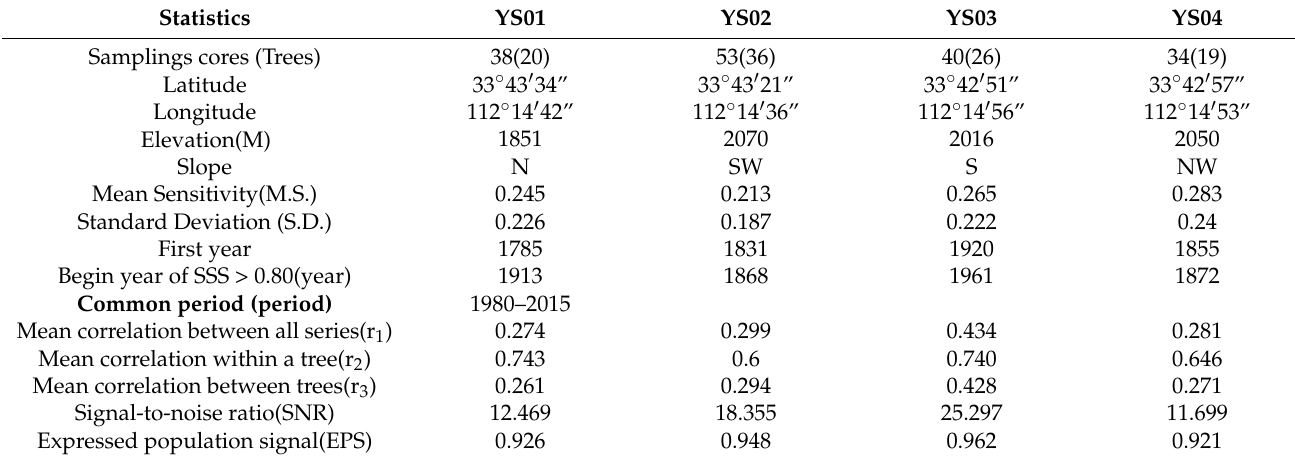
Figure 1. Locations of the sampling region (square) and sampling sites (triangle) in Mt. Yao and the nearby meteorological stations (dots) in the Funiu Mountains, central China. Table 1. Statistical characteristics of the chronologies from the four sampling sites at Mt. Yao, central